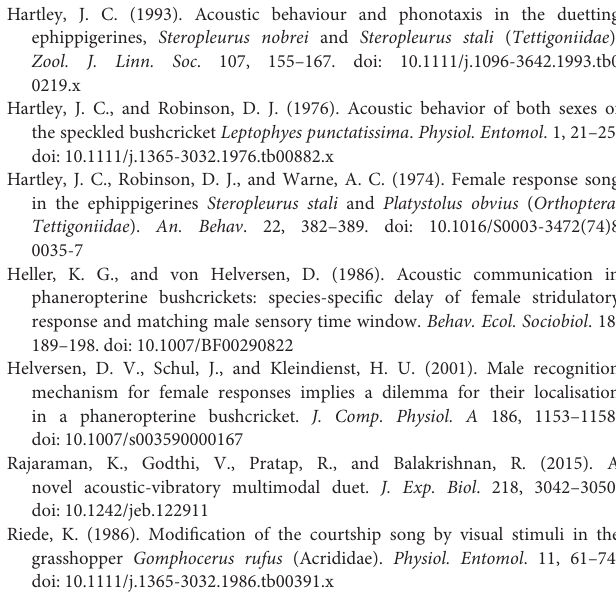
Supplementary Figure 1 | The latency of female tremulation at a separation of 4m from the male in the semi-natural experiment, using the cut vs. live branch. Supplementary Figure 2 | The latency of male vibrotaxis, at a separation of 4m from the female in the semi-natural experiment, with the cut vs. live branch. Supplementary Figure 3 | The time taken for localization by the male of the female, from an initial separation of 4m in the semi-natural experiment, on the cut vs. live branch. Supplementary Figure 4 | The sample recorded male call which was played back on repeat to females in the playback experiment. Supplementary Figure 5 | A sample spectrogram of the change in the male call over the course of a minute, with respect to the onset of tremulation, vibrotaxis, and phonotaxis, in the 9m treatment of the semi-natural